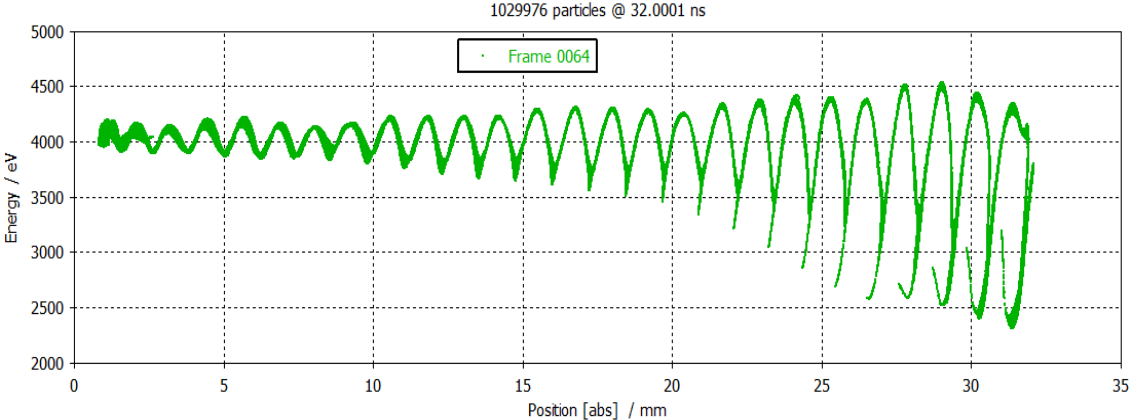
Figure 14. Phase space plot of the particles at steady state (32 ns).